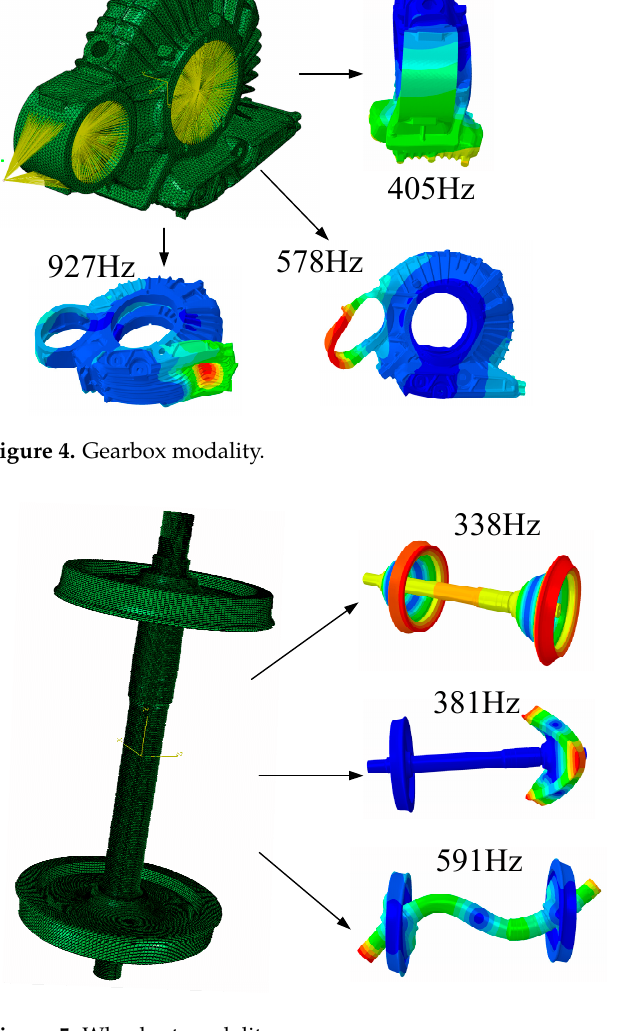
Figure 5. Wheel set modality. Figure 5. Wheel set